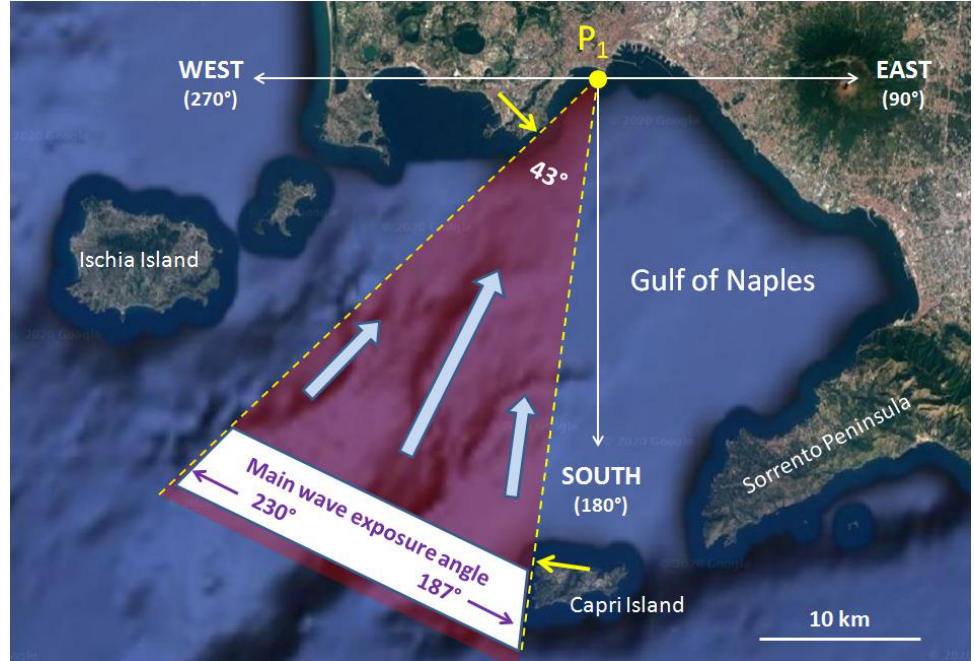
Figure 9. Main wave exposure angle relative to point P 1 in front of Via Partenope.